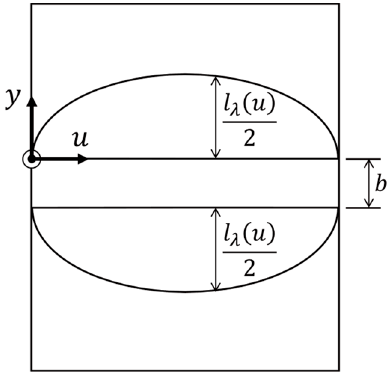
Figure 3. Required elongation of upper film.